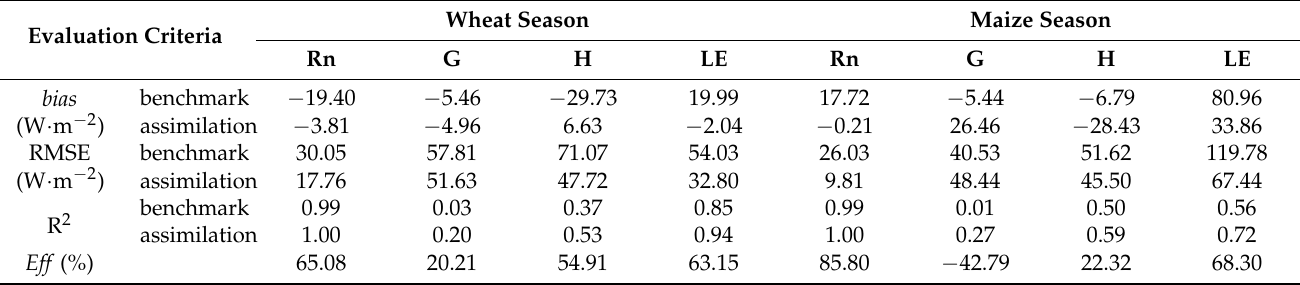
Table 6. Error statistics of surface flux